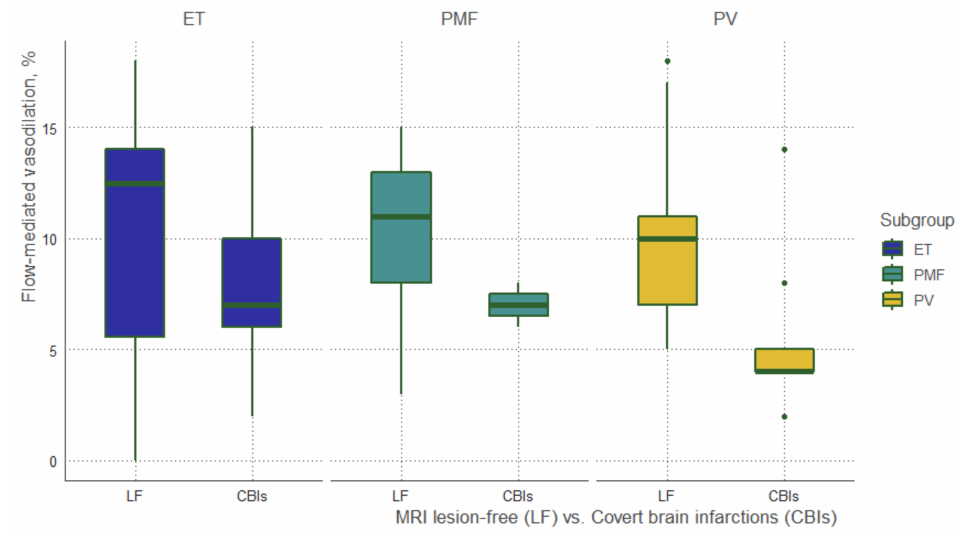
Figure 3. Flow-mediated dilation (FMD) rates. MRI lesion-free vs. CBIs. Table 3. Multivariable logistic regression